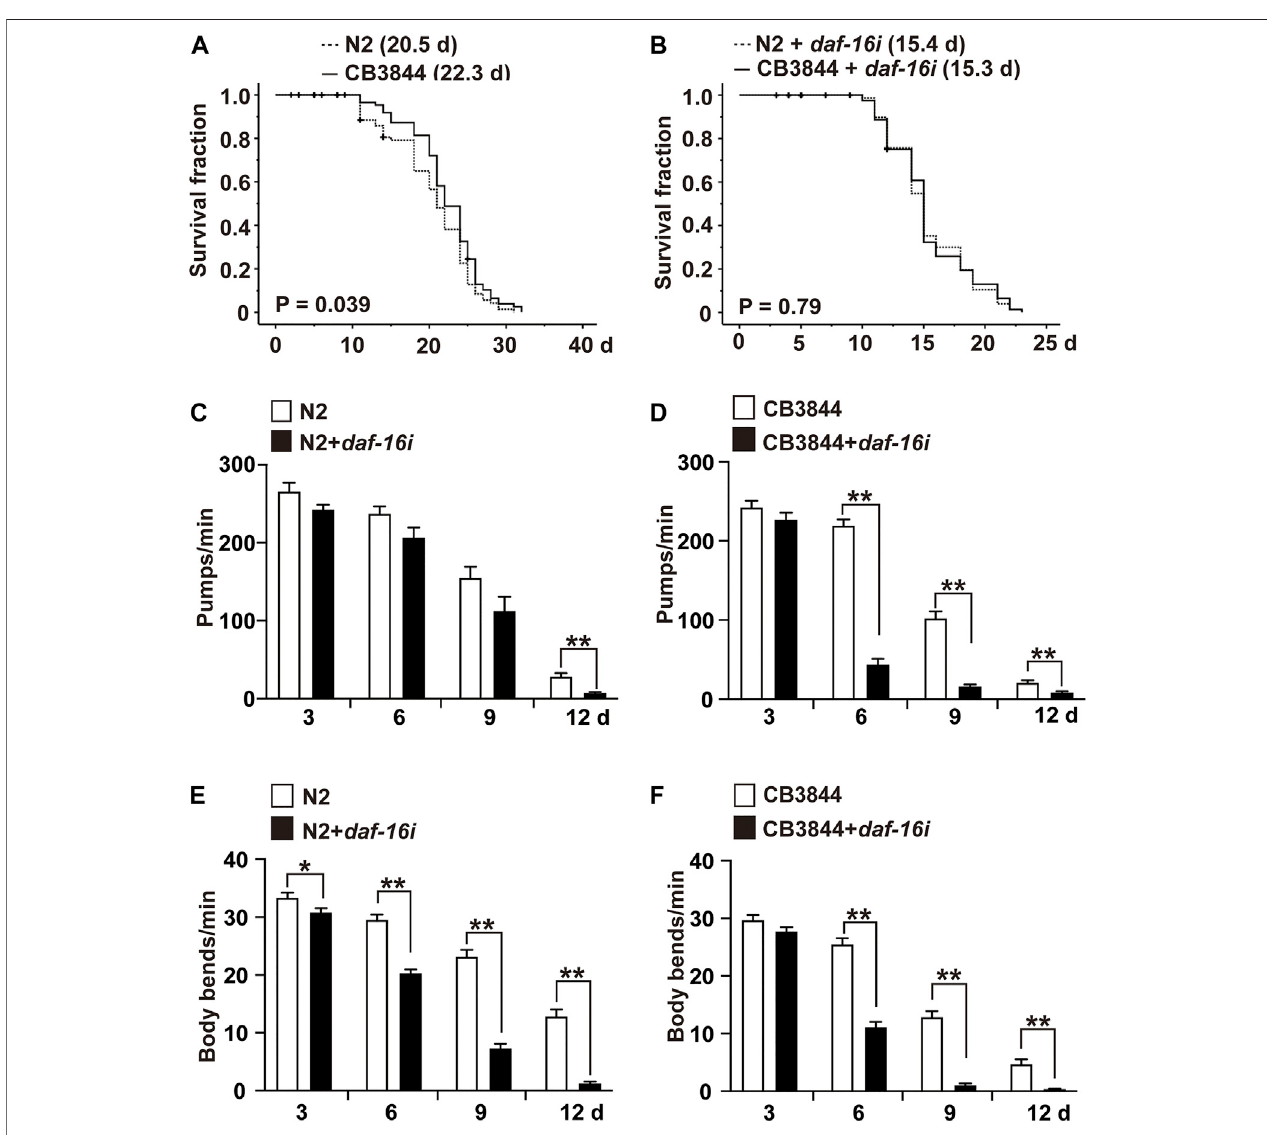
FIGURE5| DAF-16 isrequired for TRA-1-induced lifespan and healthspan. (A) SynchronizedN2 wild-type (N2) and CB3844 C. elegans L4 larvae( n (cid:1) 100/group) werefed E.coli OP50bacteria,followedbyKaplan-Meieranalysis,asdescribedabove. (B) SynchronizedN2wild-typeandCB3844 C.elegans L4larvae( n (cid:1) 100/group) werefed E.coli HT115bacteriatransfectedwith daf-16 RNAi( daf-16i ),andthemeanlifespanwasevaluatedbyKaplan-Meieranalysis. (C) SynchronizedN2wild-type C. elegans worms ( n (cid:1) 20/group) were fed daf-16 RNAi-transduced E. coli HT115 bacteria (N2+ daf-16i ) or nontransduced E. coli HT115 bacteria (N2). After 3, 6, 9, and12 daysoftreatment,thepharyngealpumpingrateofindividualwormswasdetectedfor60 s. (D) SynchronizedCB3844 C.elegans werefed E.coli HT115bacteria transfected with daf-16 RNAi (CB3844+ daf-16i ) or untransfected E. coli HT115 bacteria (CB3844), and the pharyngeal pumping rate per minute (Pumps/min) was detected at Days 3, 6, 9, and 12. Twenty worms were examined in each group. (E) Synchronized N2 wild-type C. elegans ( n (cid:1) 50/group) were treated as described above, andthebodybends/minwerecountedfor60 satDays3,6,9,and12. (F) SynchronizedCB3844 C.elegans werefedasdescribed above,andthebodybends/ min were